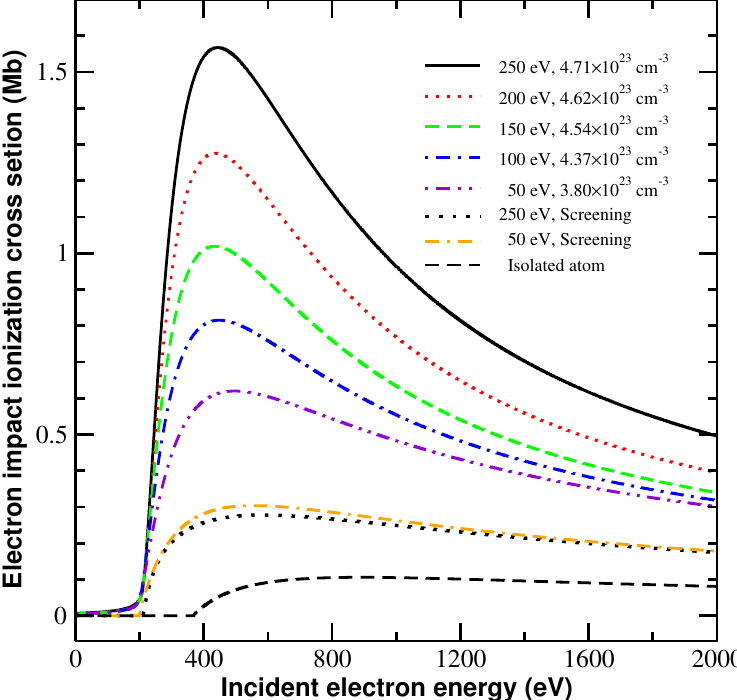
Figure 2. Enhanced collisional ionization integral cross section. The electron-impact ionization e + 1 s 2 2 s 2 S → 1 s 2 1 S + 2 e of Mg 9 + occurs in solid-density magnesium plasma at electron temperatures and densities of 250 eV and 4.71 × 10 23 cm − 3 (solid black line), 200 eV and 4.62 × 10 23 cm − 3 (dotted red line), 150 eV and 4.54 × 10 23 cm − 3 (dashed green line), 100 eV and 4.37 × 10 23 cm − 3 (dot-dashed blue line), and 50 eV and 3.80 × 10 23 cm − 3 (dot-dot-dashed violet line). The integral cross sections obtained by the screened-ion model are weakly temperature-dependent and, thus, for clarity, we only show the results at the highest (250 eV) and lowest (50 eV)